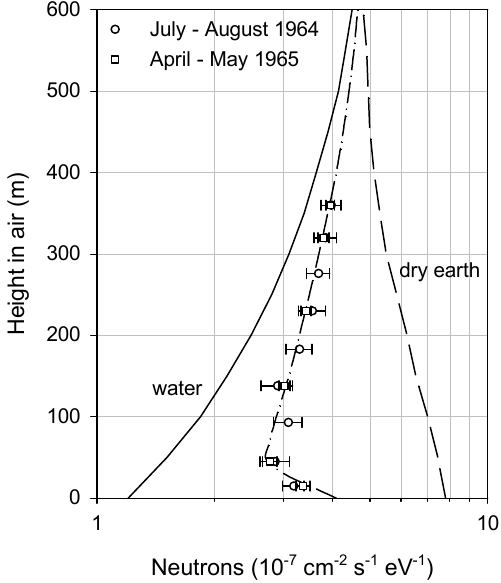
Fig. 2. Distribution of “fast” neutrons above the Earth’s sur- face showing strong dependence on surface moisture. Circles and squares are measurements on a radio tower. A theoretical model that best fits the data (dash-dotted line) suggests a soil moisture of 0.03m 3 m − 3 to 0.05m 3 m − 3 . Replotted from Hendrick and Edge (1966).